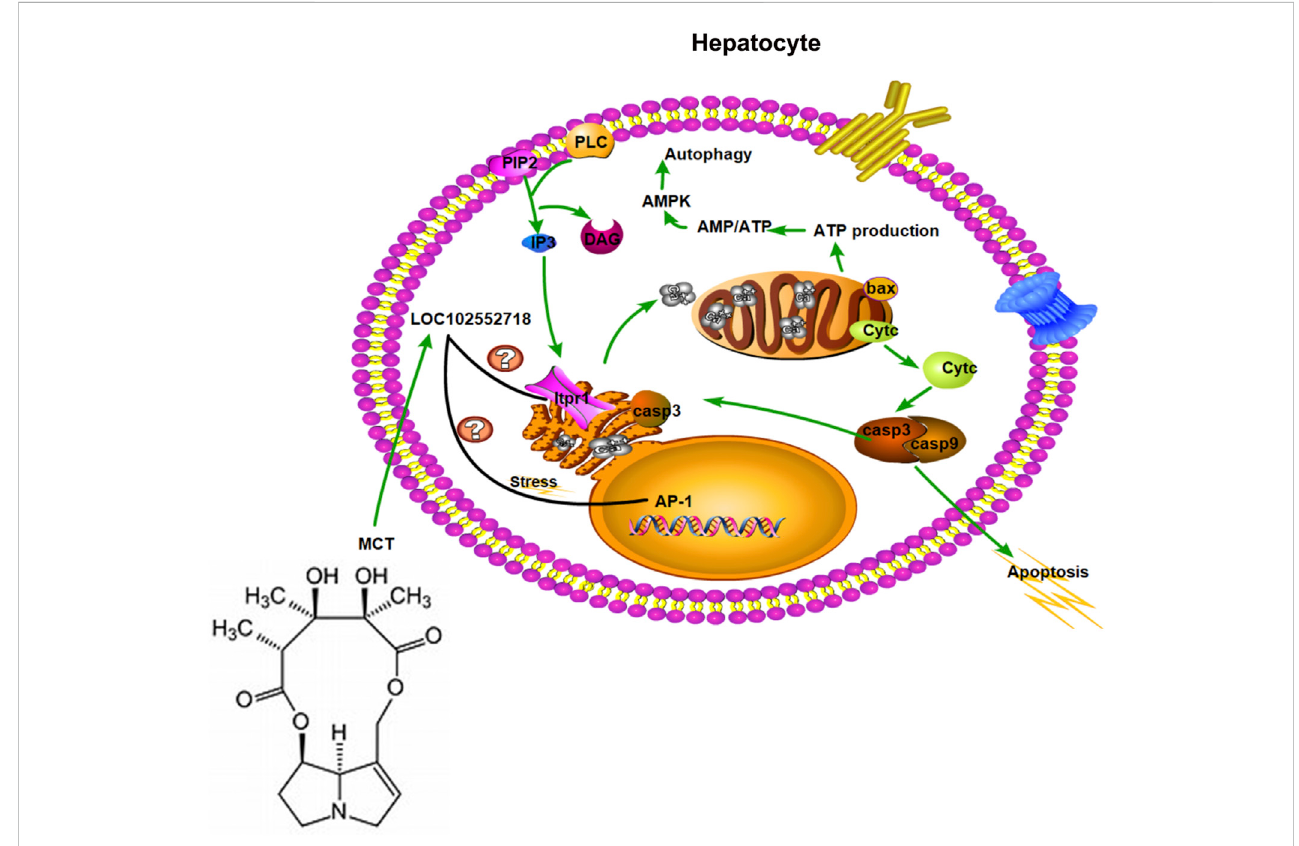
FIGURE 8 Hypothesized role of LOC102552718 with Itpr1 in hepatotoxicity induced by